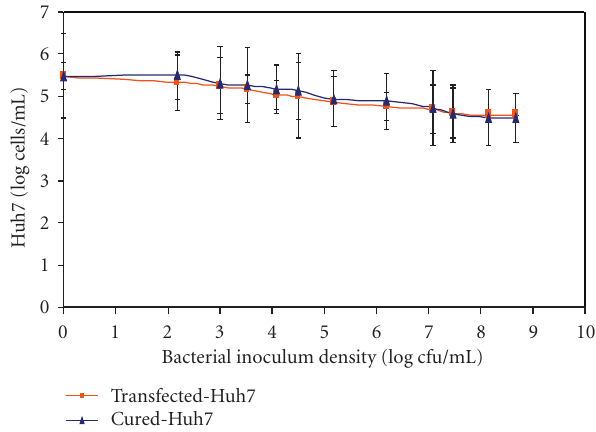
Figure 1: Growth of transfected- and cured Huh7 cells in cocultures with H. bilis at di ff erent inoculum densities. The initial number of Huh7 cells determined by the improved Neuber cytometer after staining with trypan blue was ca. 10 5 . 5 cells/ml. The number of viable Huh7 cells counted after 48 h in cocultures with H. bilis are shown in the figure. The values represent the mean count of Huh7 cells from three independent